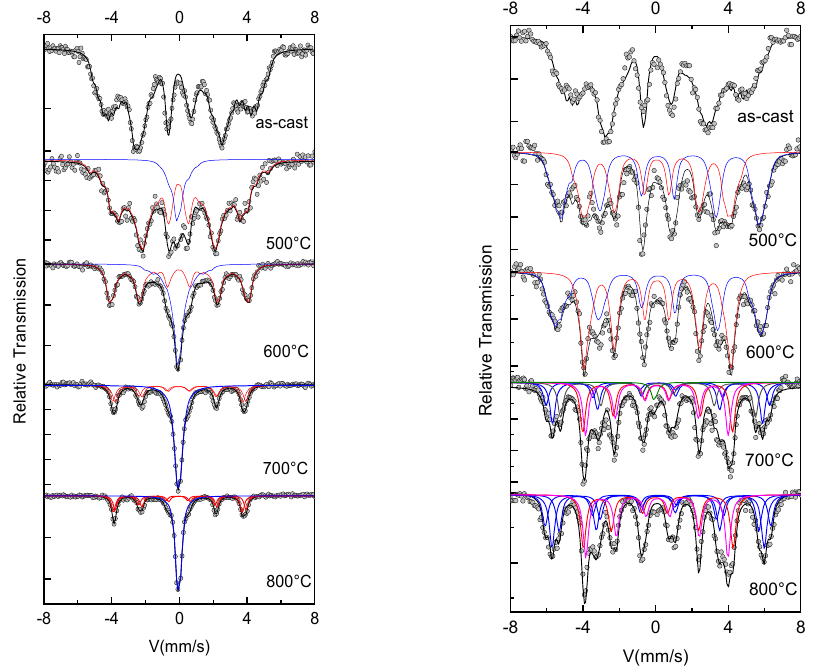
Figure 6. 300 K and 77 K Mössbauer spectra of as-cast and annealed samples. Table 2. Hyperfine parameters obtained from the fitting of the 300 K and 77 K Mössbauer spectra. is the isomer shift, /2 is the half width at half maximum (HWHM) of the line, 2 is the quadrupolar splitting, and Bhf is the hyperfine field.